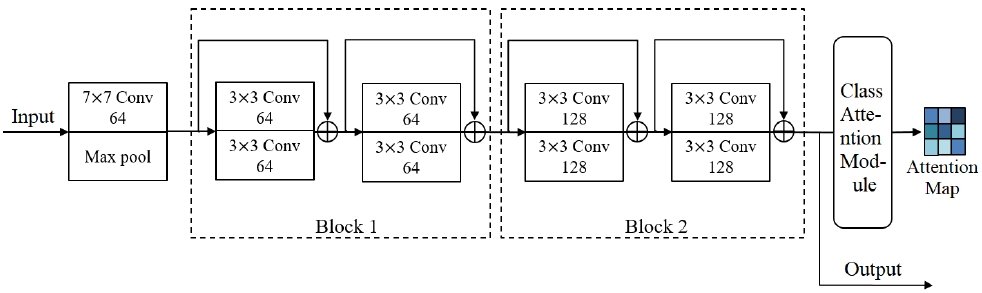
Figure 4. The architecture of deep embedding